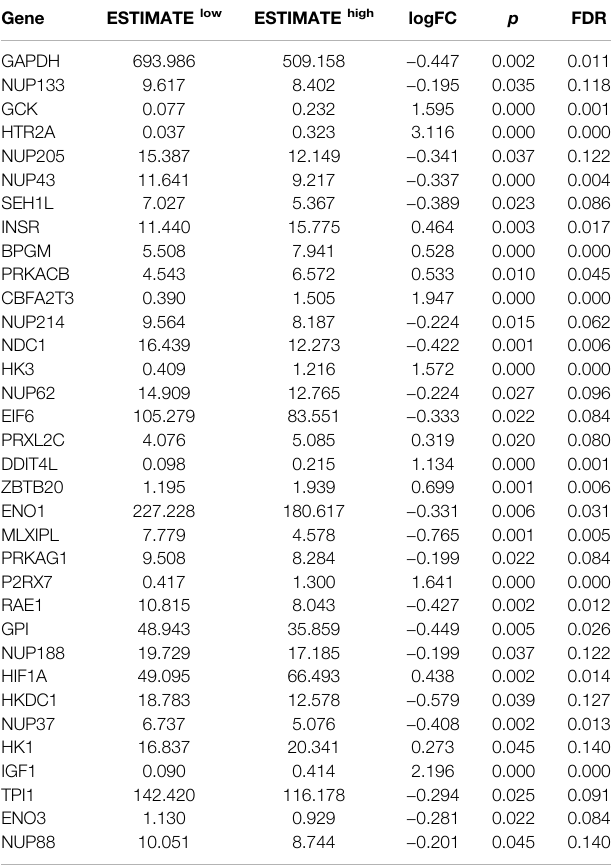
TABLE1| Signi fi cantIGexpressionlevelsintheESTIMATE low andESTIMATE high